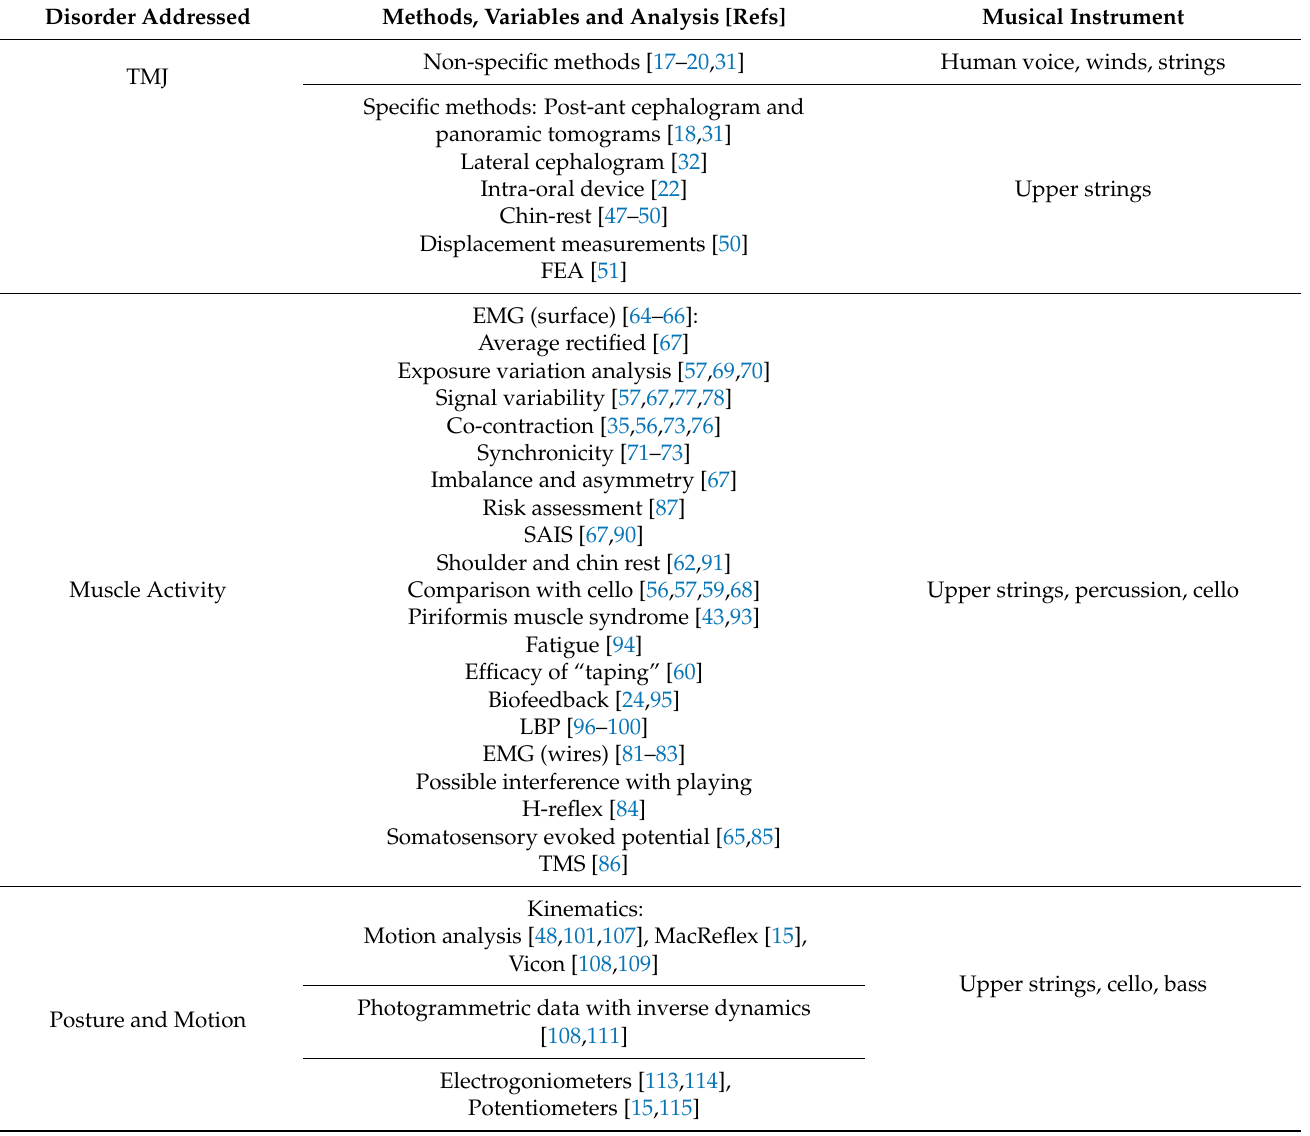
Table 1. Summary of methods, variables and analyses used for identifying and evaluating vocation-related neuro- musculoskeletal deficiencies in professional musicians (abbreviations used: TMJ = temporo mandibular joint; Post-ant = postero-anterior; EMG = electromyogram; SAIS = subacromial impingement syndrome; TMS = transcranial magnetic stimulation; LBP = low back